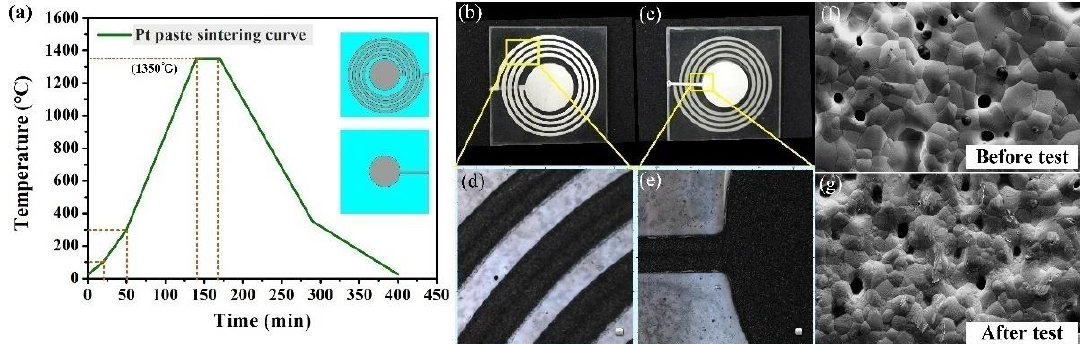
Figure 4. ( a ) Sintering curve of Pt conductor. ( b , c ) The top and bottom layers of the sensor. ( d , e ) The partially enlarged details of the inductors. ( f , g ) SEM images of Pt before and after high-temperature pressure testing.